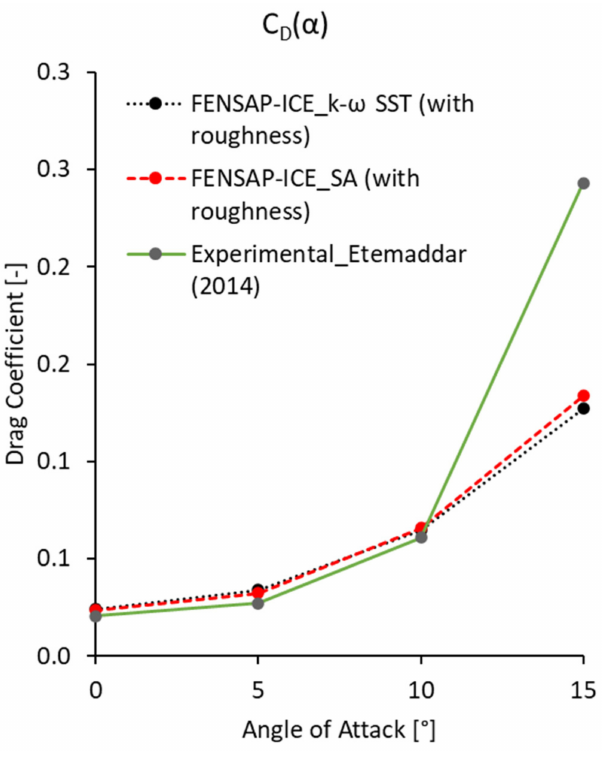
Figure 12. Drag coefficient with different turbulence models in comparison with experimental results